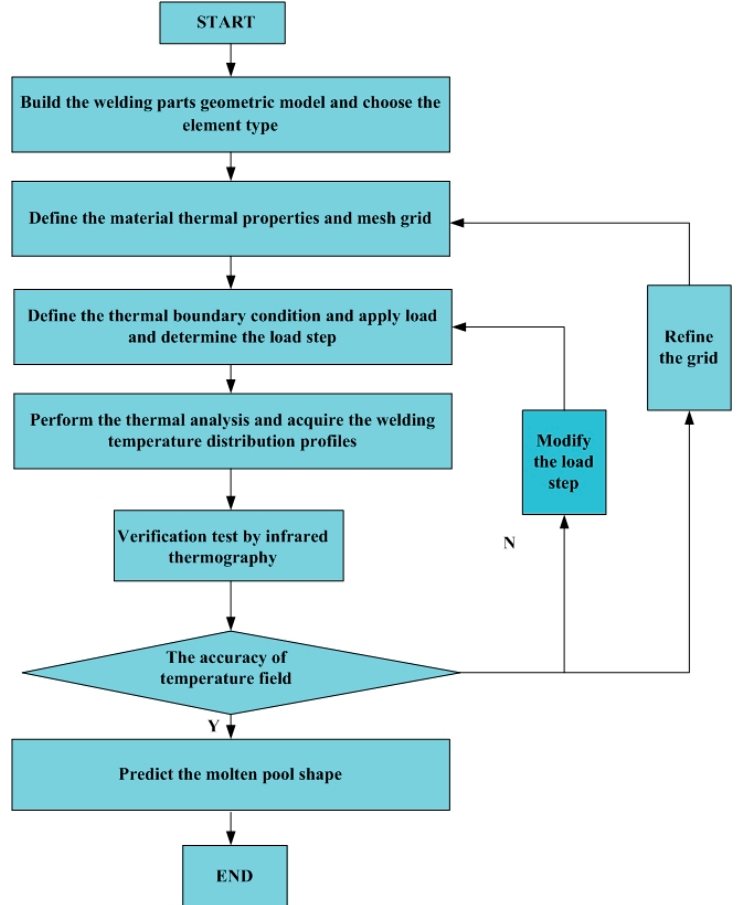
Figure 3. Flowchart of the numerical simulation procedure. Table 3. The thermal property parameters of 443 stainless